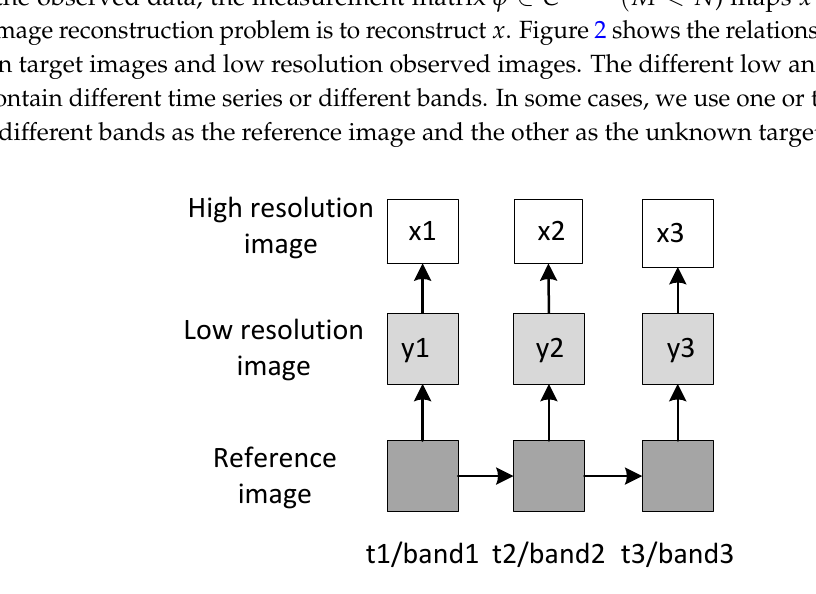
Figure 2. Relationship between the high resolution image and the low resolution